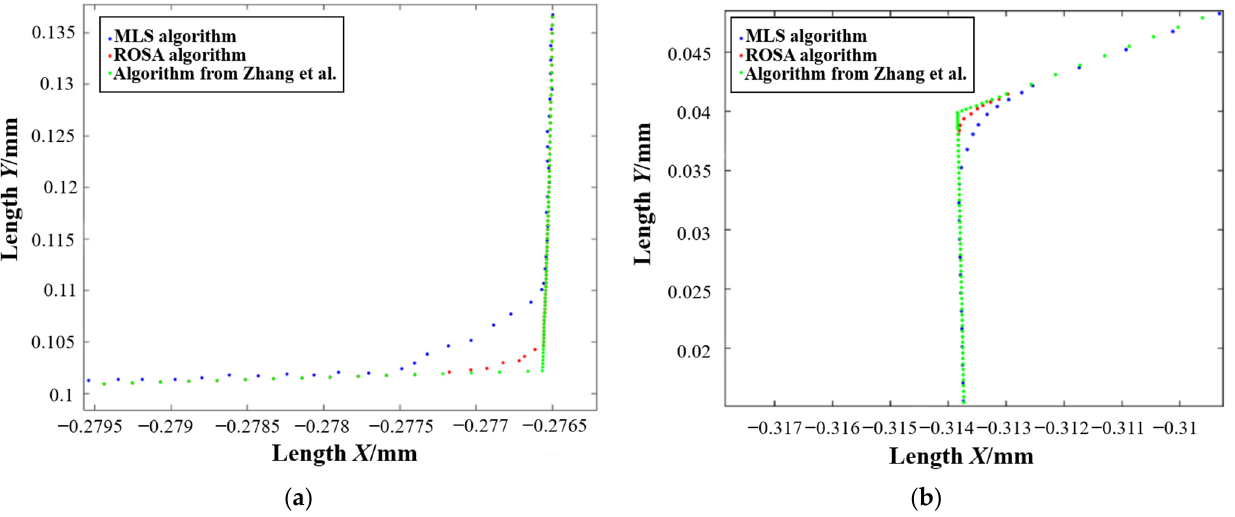
Figure 3. Magnified angle diagram of ring forging section line extracted by three algorithms in ( a ) second order and ( b ) third order with permission from [39], 2021, Elsevier.